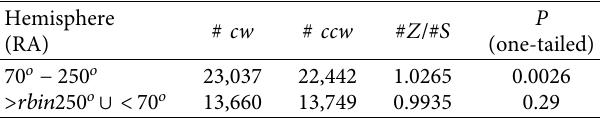
Table 11: The number of clockwise and counterclockwise spiral galaxies in the exact same dataset used in [68] in the hemisphere centered at α � 160 o , and in the opposite hemisphere, centered at α � 340 o . The P values are based on binomial distribution such that the probability of a galaxy to spin clockwise or counterclockwise is 0.5.